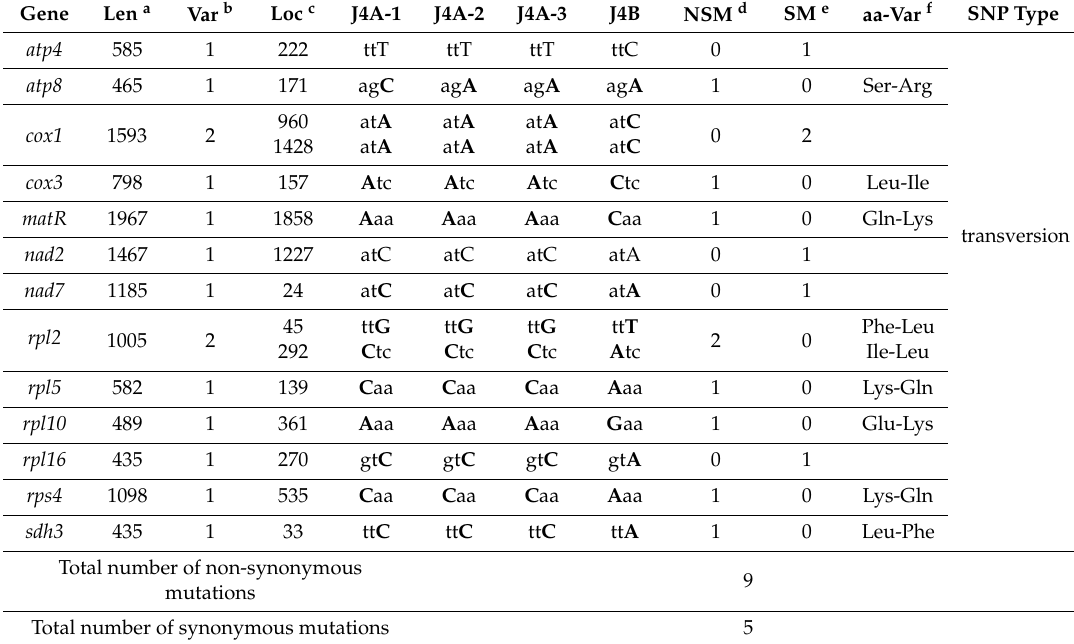
Table 5. The protein variation in the two